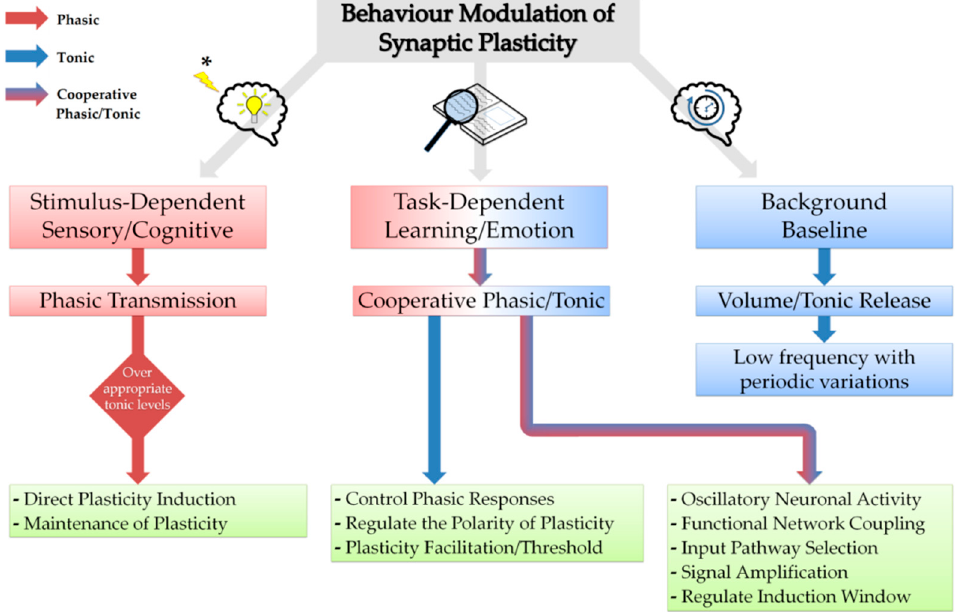
Figure 3. A model of behaviour-dependent neuromodulation of synaptic plasticity. Tonic release of neuromodulators controls baseline and task-induced levels which mediate attention. The cooperative actions of tonic and phasic release during learning tasks modulate network activity and neuronal oscillations that prime plasticity induction through functional coupling, pathway selection and signal amplification. Salient stimuli such as unexpected novelty and reward cues (in rodent models) trigger sub-second phasic transmission to provide the induction / maintenance signal provided that background / tonic levels are “appropriate” for induction. * Salient stimulus.